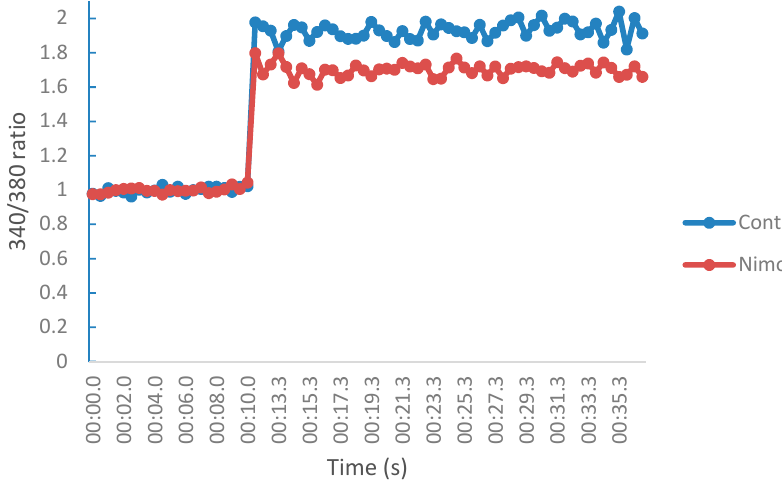
Figure 8. Fluorescence profile of SH-SY5Y neuroblastoma cells in a Fura-2 based assay in the presence or absence of test sample (Nimodipine) for voltage gated Ca 2+ -studies.